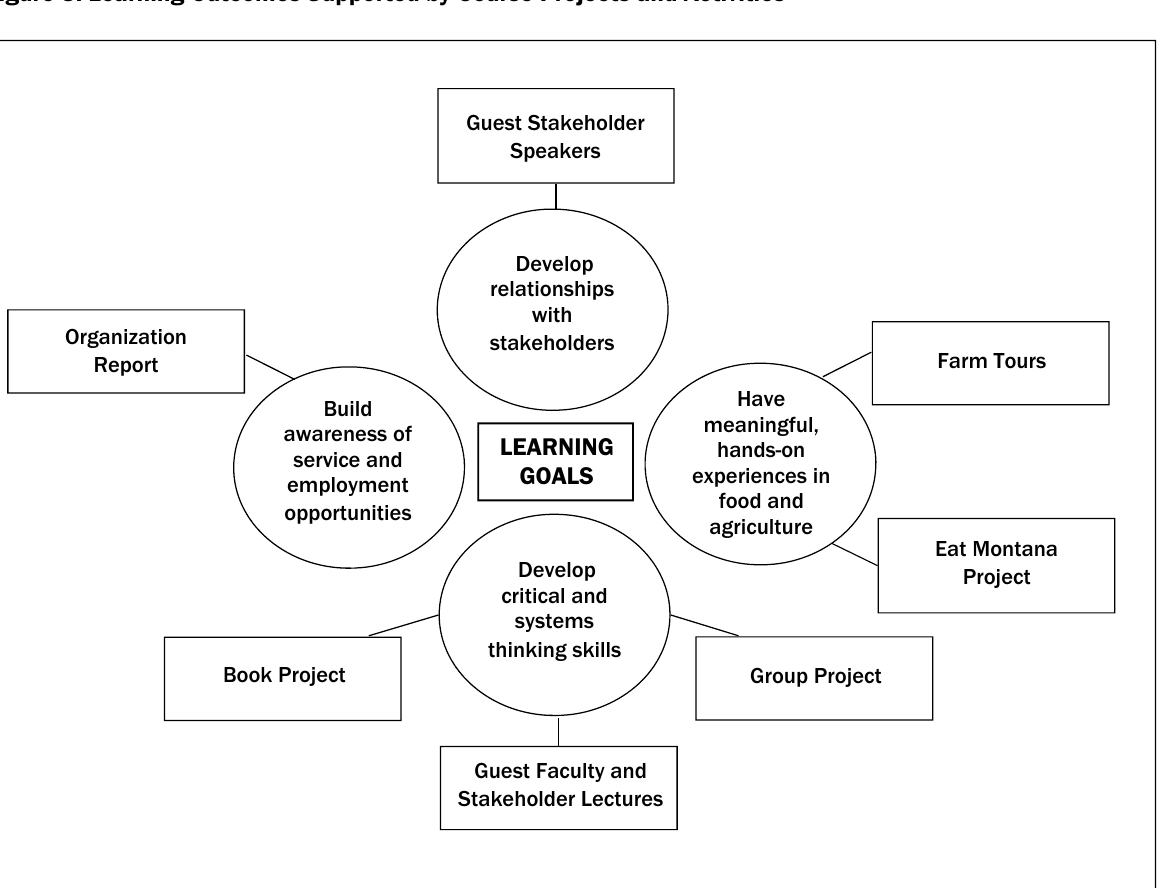
Figure 3. Learning Outcomes Supported by Course Projects and